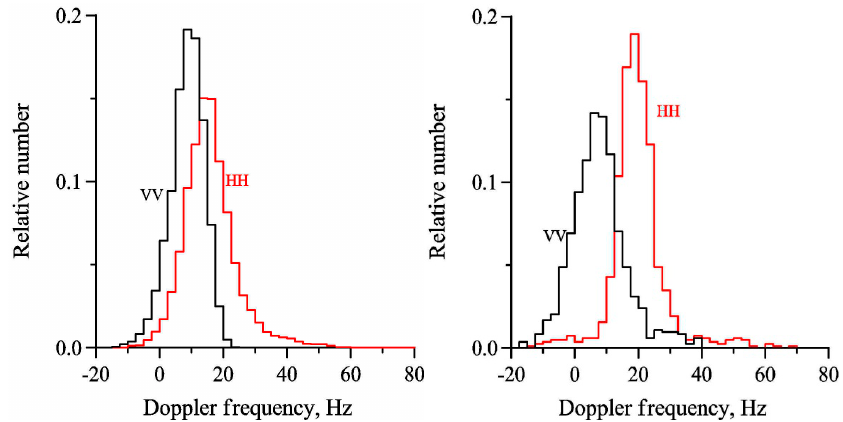
Figure 10. Histograms of radar Doppler shifts in non-slicks ( left ) and in slicks ( right ). Wind velocity is 10 m/s.